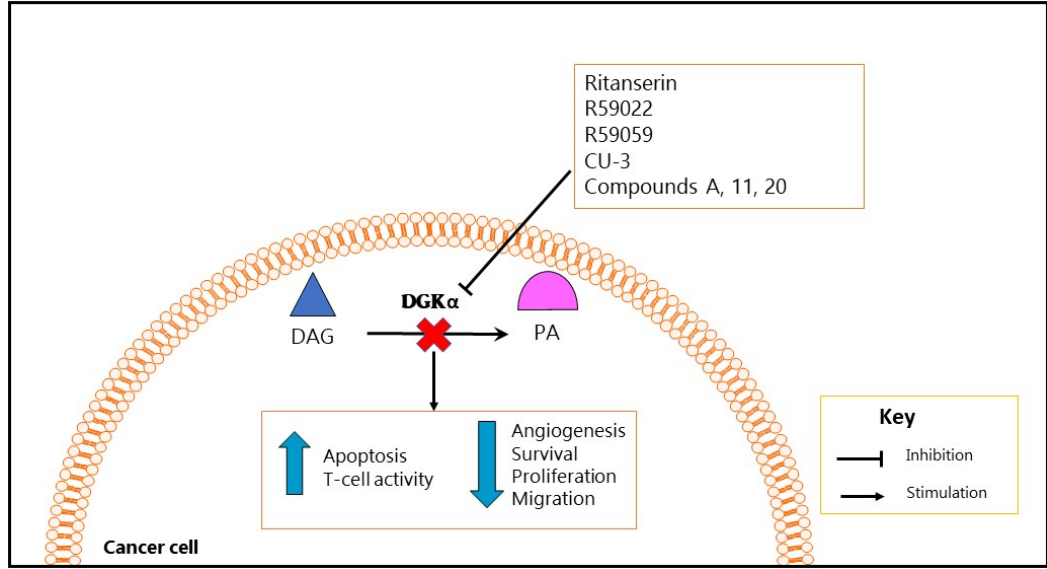
Figure 2. Functional effects produced by DGKα inhibition in cancer. The use of DGKα specific or pan inhibitors to inhibit DGKα activity in cancer cells seems to block cancer progression through the inhibition of cancer-promoting mechanisms, such as growth and survival. Intriguingly, inhibition of DGKα activity increases apoptosis in several cancer cell lines and in vivo tumor models, while enhancing T-cell activity or immune response.